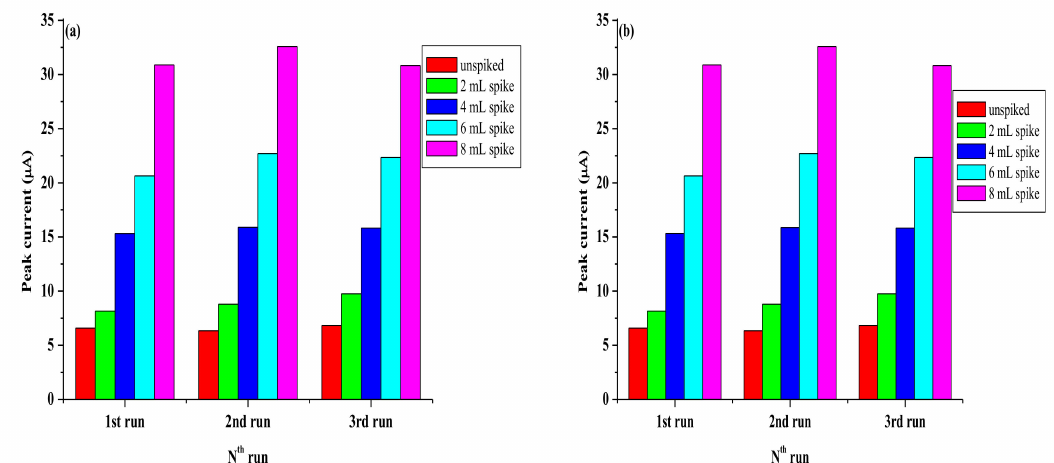
Figure 20. The precision of the electrodes towards the Pb 2+ analyte concentration at ( a ) SPCE/LPE/BiONPs/PANI and ( b )